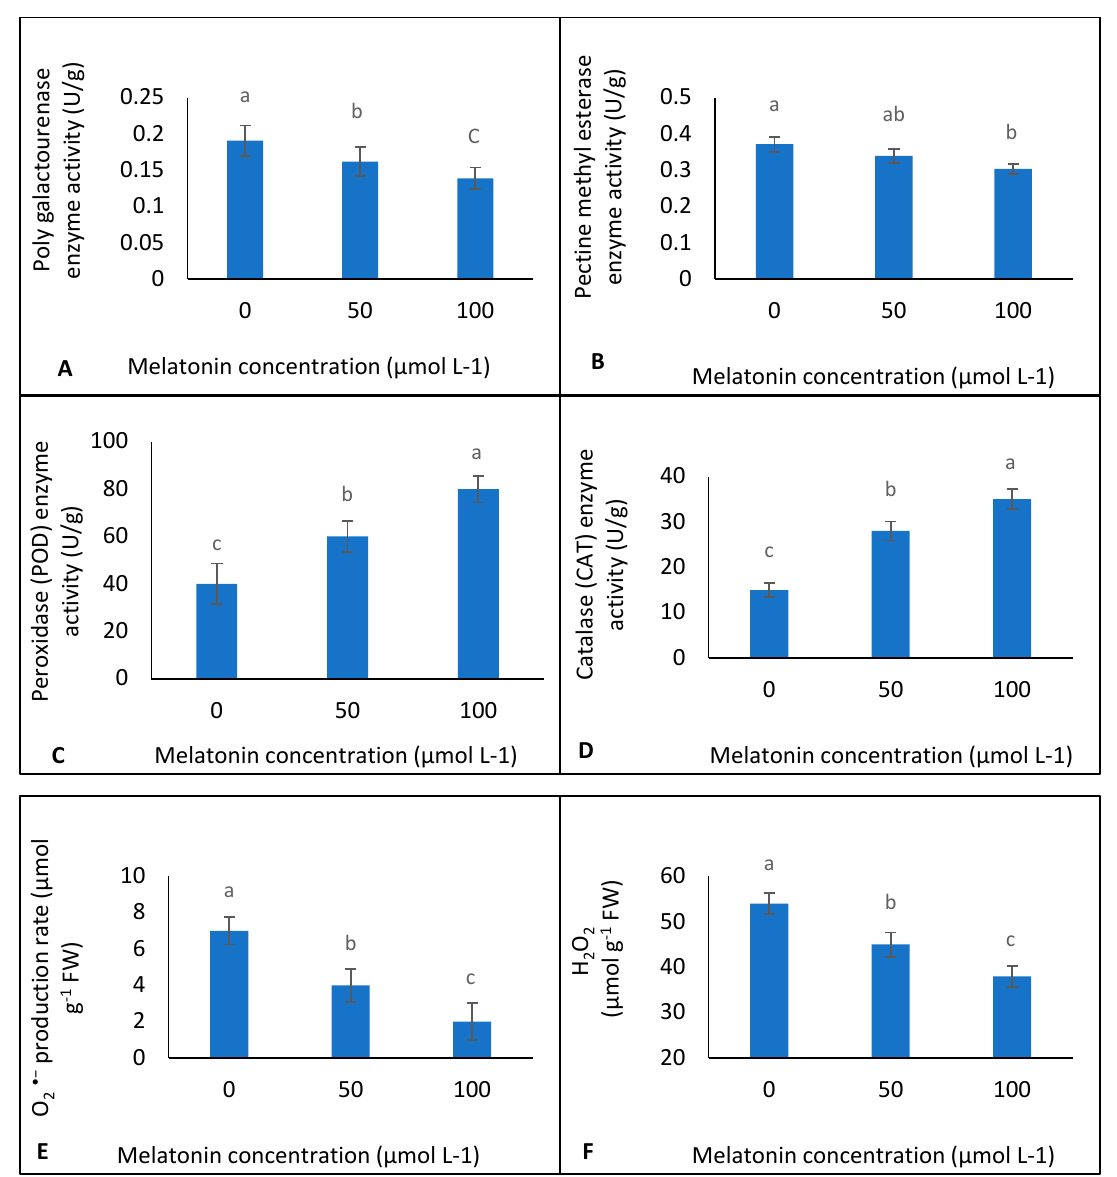
Figure 4. Effect of three concentrations of melatonin on ( A ) PG enzyme activity, ( B ) PME enzyme activity, ( C ) POD activity, ( D ) CAT activity, ( E ) O 2• − production rate, and ( F ) H 2 O 2 of grape berry stored at 0 °C after 35 days of storage. Values are means ± SE from five replicates ( n = 5). Same letter means no significant differences between the values ( p < 0.05) according to the Tukey test.